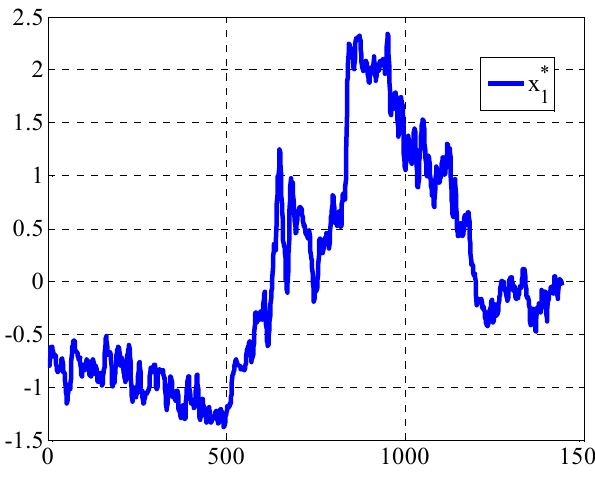
of boiler thermal efficiency (1# boiler). 1 x